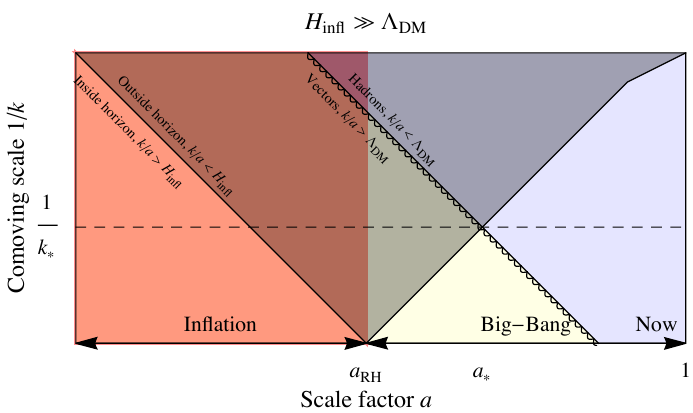
Figure 4 . Evolution during and after inflation of the relevant scales, assuming instantaneous reheating at inflation end, when a = a . The black continuous curve is the horizon, and the RH region beyond the horizon is shaded in gray. The half-wavy line is the transition from vector to hadron modes. The special mode k is the one that, after inflation at a = a , re-enters the horizon ∗ ∗ while transitioning from vector to